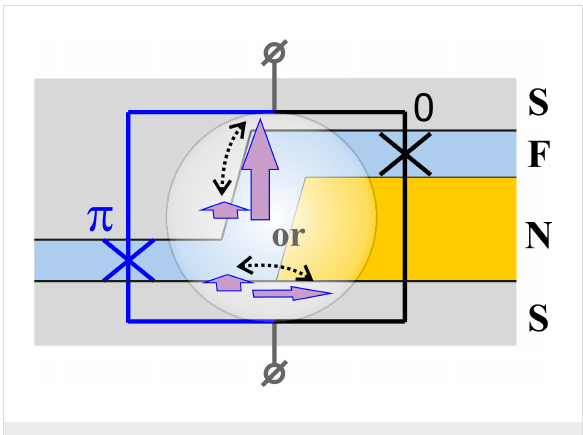
Figure 15: Cross section of an SF-NFS MJJ with CPRs of its parts shifted in phase by π . Arrows show F-layer magnetization directions corresponding to the on/off states of the